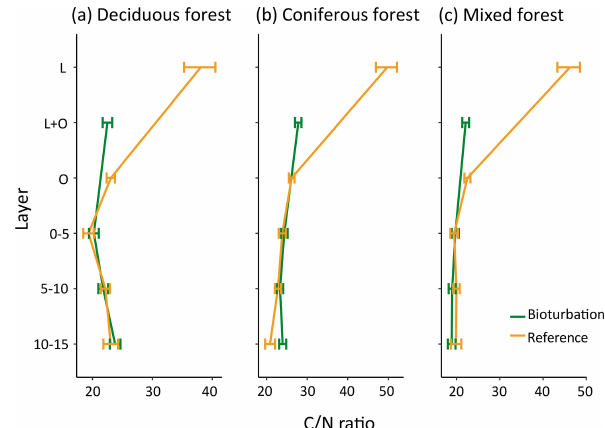
Figure 6. Mean carbon : nitrogen (C / N) ratio of organic matter in different forest floor layers and mineral soil layers in disturbed and reference plots in deciduous ( n = 6), coniferous ( n = 11) and mixed forest ( n = 6). Bars indicate standard